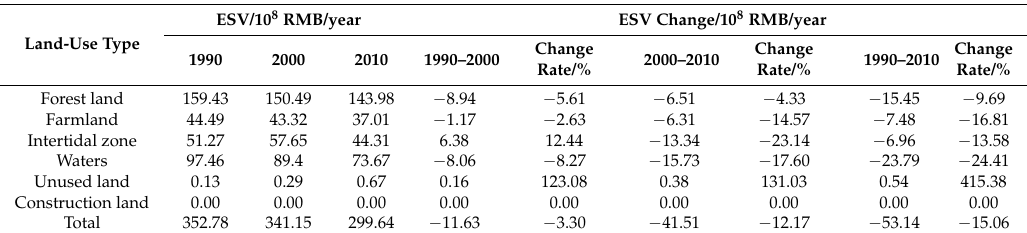
Table 5. Changes of ecosystem service value (ESV) in the coastal zone in Zhejiang Province from 1990 to 2010.